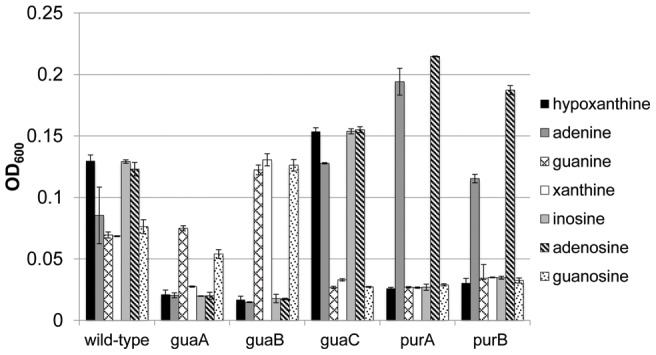
Growth of gua and pur mutants in EMF12 supplemented with individual purines.
H. pylori strains were grown in EMF12 supplemented with one of seven purine sources. After 20 hours, the optical density was measured. Positive growth was defined as a statistically significant increase in OD600 relative to the baseline OD600 of 0.025 (student's t-test, P<0.05). Results are the mean ± SD of three independent growth cultures.